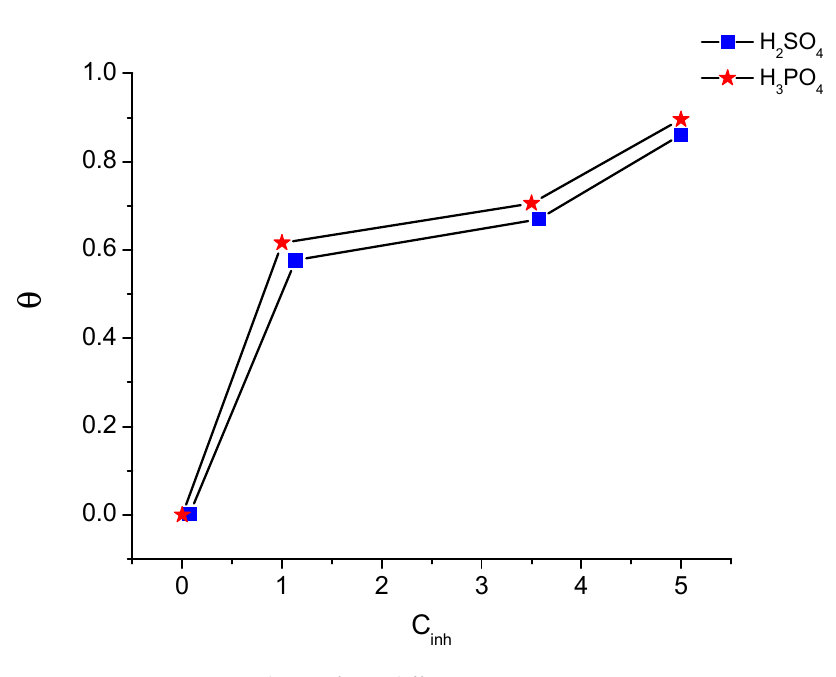
Materials 2019 , 12 , x FOR PEER REVIEW Figure 6. S-shape of θ at di ff erent ASMS concentrations. Figure 6. S-shape of θ at different ASMS concentrations.